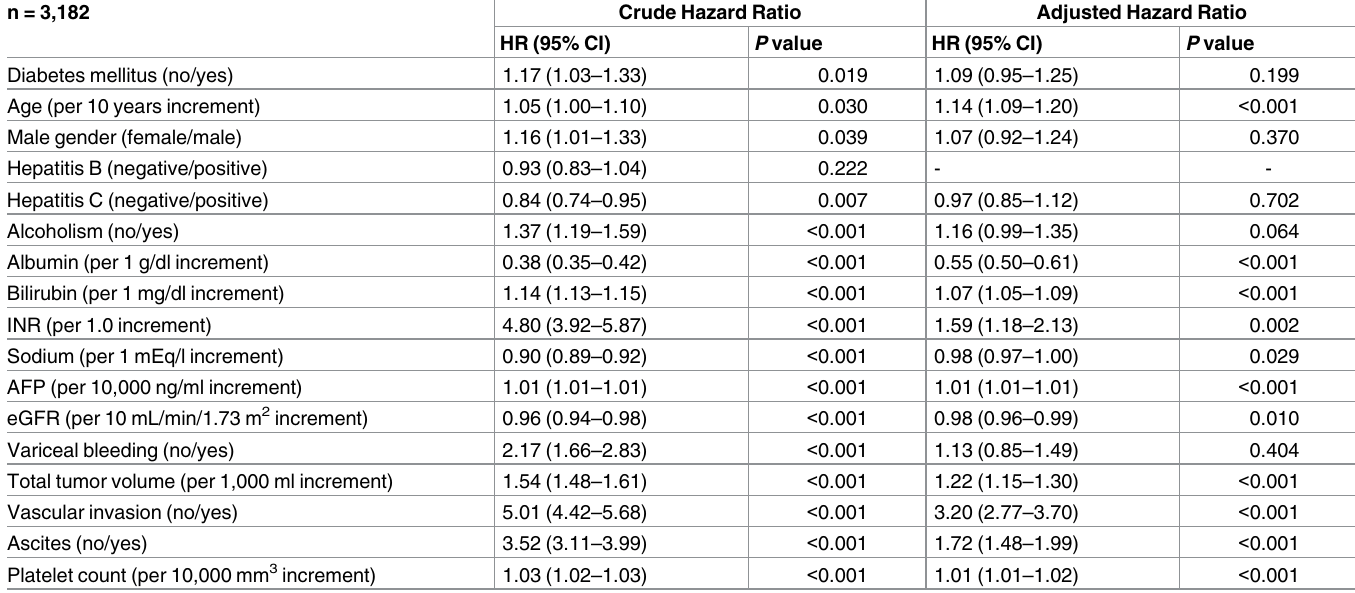
Table 2. Univariate and multivariate Cox survival analysis in the entire hepatocellular carcinoma cohort. n = 3,182